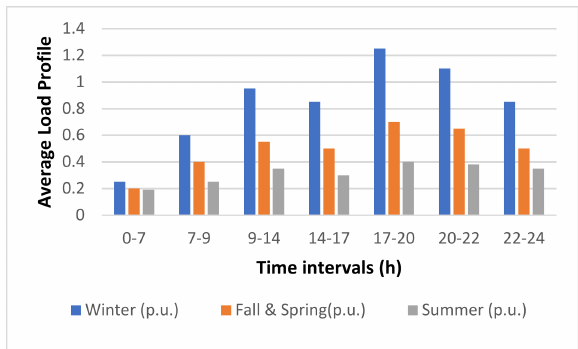
Figure 1. Average load profile for different seasons and time